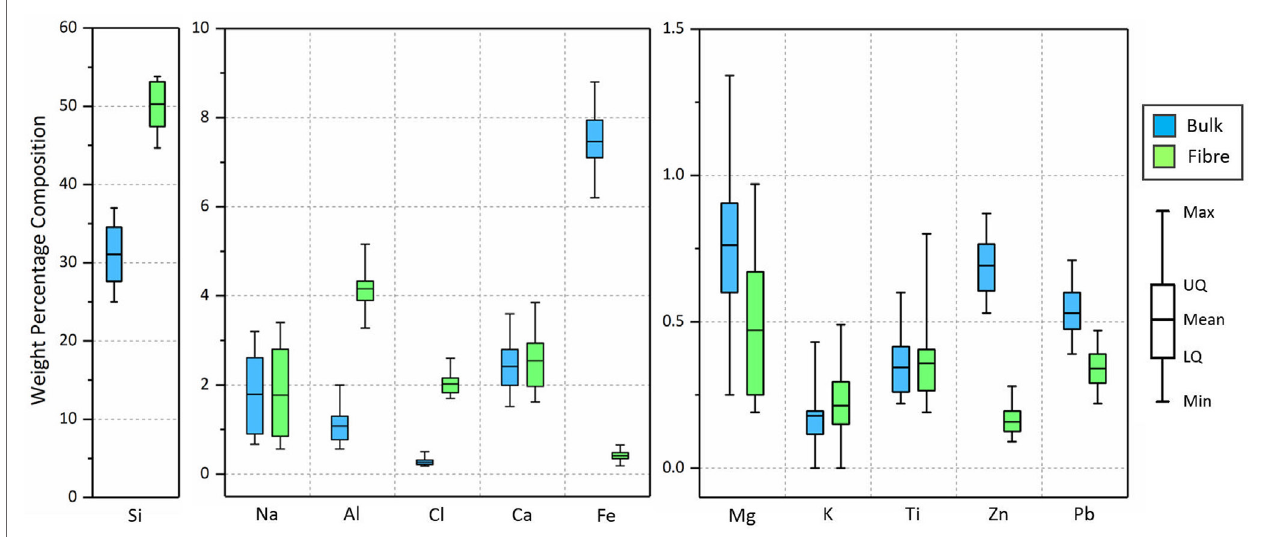
FigUre 2 | Elemental comparison of both the fibrous regions and surrounding bulk particle. Data from all three particles comprises the results presented in this